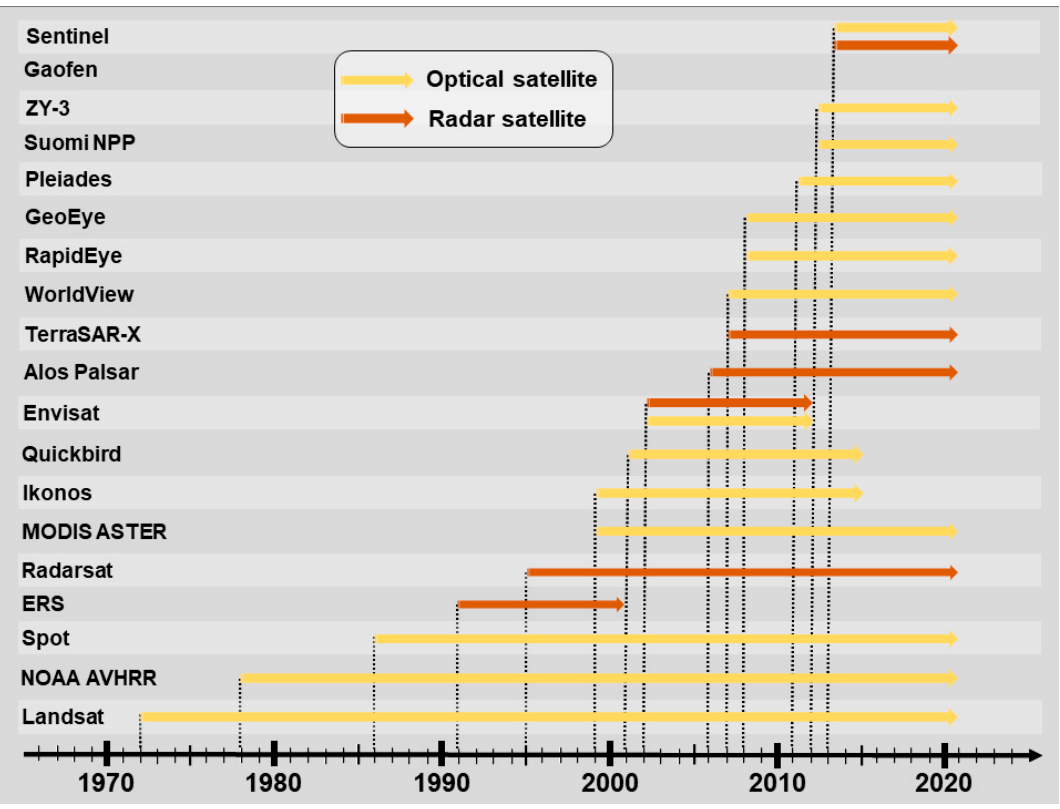
Figure 4. Earth observation optical and radar satellites commissioning and time of service chronology.